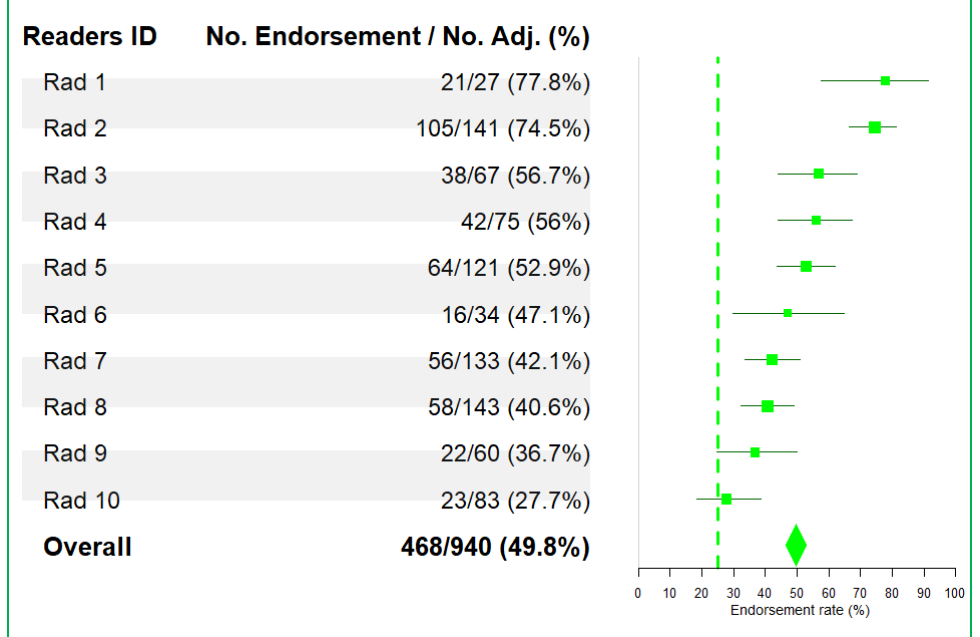
Figure 3. Reader endorsement rates after adjudication: Adjudication was based on discrepancy in the DOP. The dashed green line at 25% indicates a significant difference from the average reader endorsement (50%) for readers involved in more than 25 adjudications.